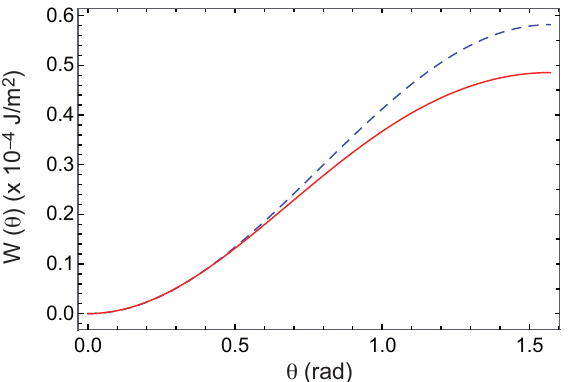
Figure 13. Comparison between the best Rapini–Papoular potential (blue dashed curve) and the best modified Rapini–Papoular potential (red solid curve). The two potentials are almost indistinguishable below θ = 0.4 rad, meaning that in our experiment, the Rapini–Papoular potential can be used to fit the